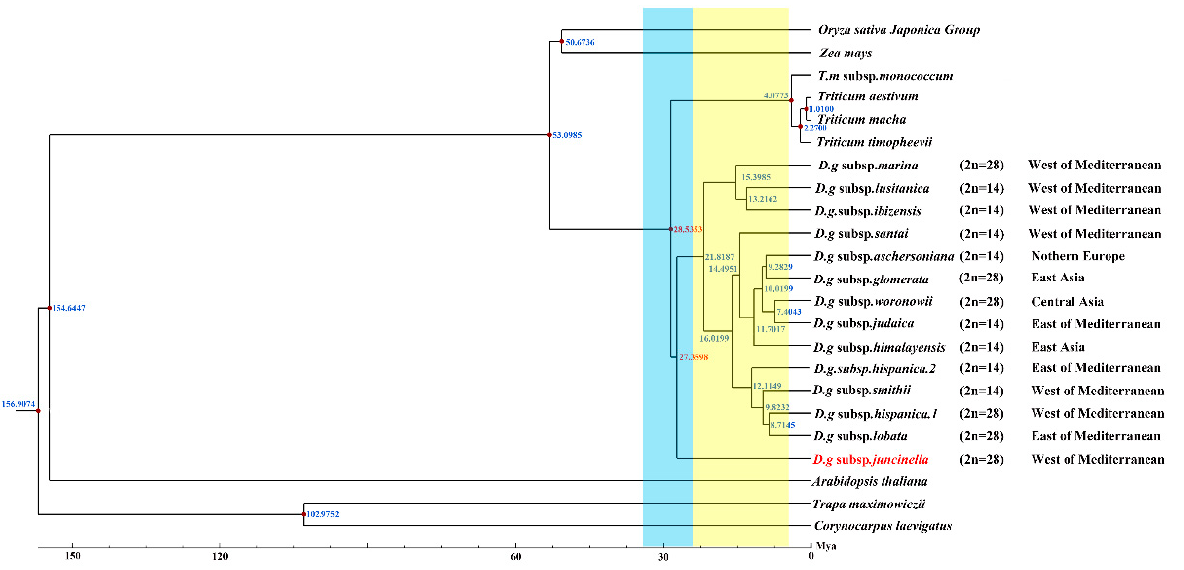
Figure 7. Divergence time of D. glomerata subspecies. Molecular dating of 14 Dactylis subspecies based on the cp genome sequences in cp genomes. Blue bar represents Oligocene period and yellow bar represents Miocene period.